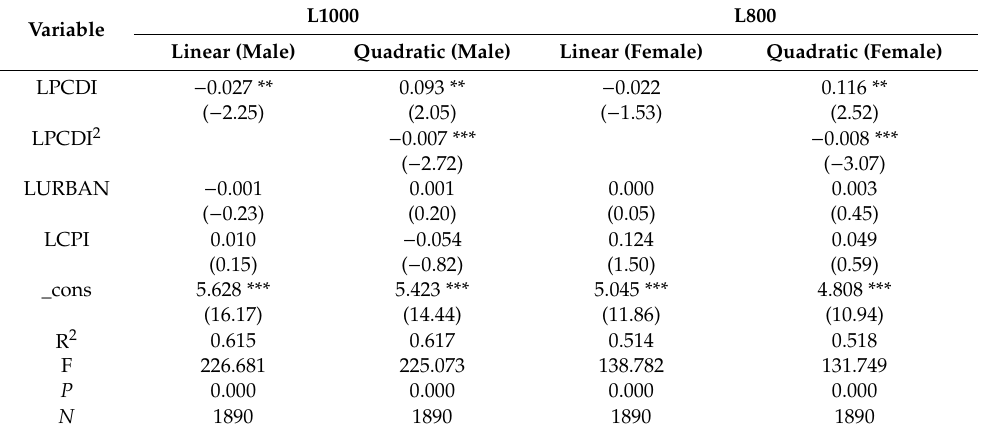
Table 5. Econometric Estimates of the Relationship Between PCDI and CRF of